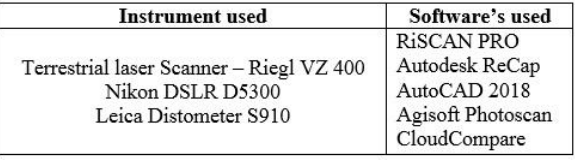
Table 2: Instrument and Softwares used